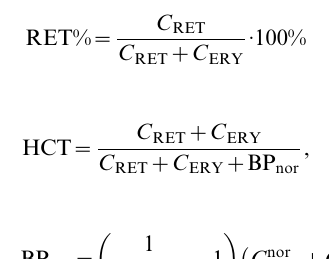
Upper part: Data sets regarding application of different EPO derivatives in healthy volunteers. Lower part: Chemotherapy data sets, those with access to raw data are indicated with an asterisk. HD=Hodgkin’s disease, NHL=aggressive non-Hodgkin lymphoma.